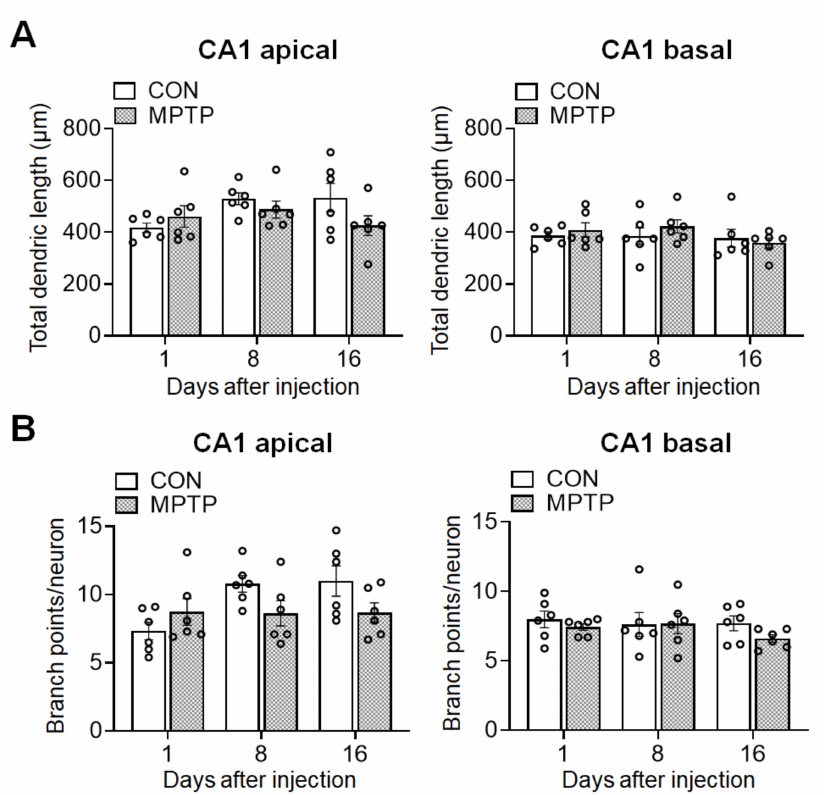
Figure 3. Acute MPTP treatment did not alter the dendritic length and branch points in cornu ammonis 1 (CA1) pyramidal cells. The bar graphs represent the total dendritic length ( A ) and branch point counts ( B ) in the apical (left panels) and basal (right panels) CA1 of the control (CON) and MPTP-treated groups. Data are expressed as the mean ± standard error ( n = 6